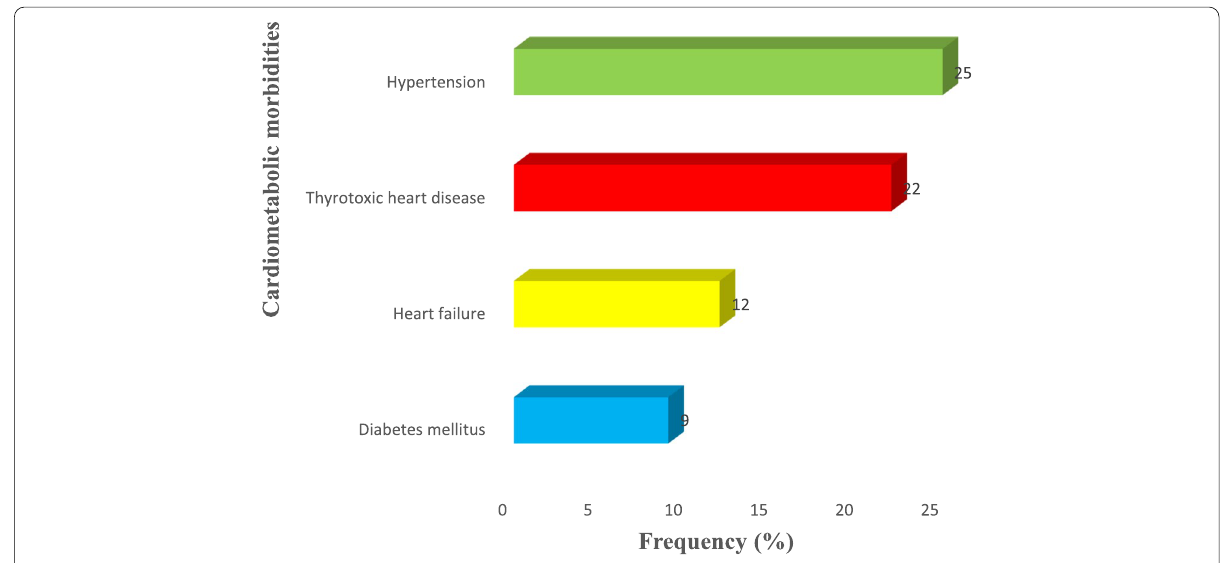
Fig. 22 Pooled frequencies of cardiometabolic morbidities in thyrotoxicosis